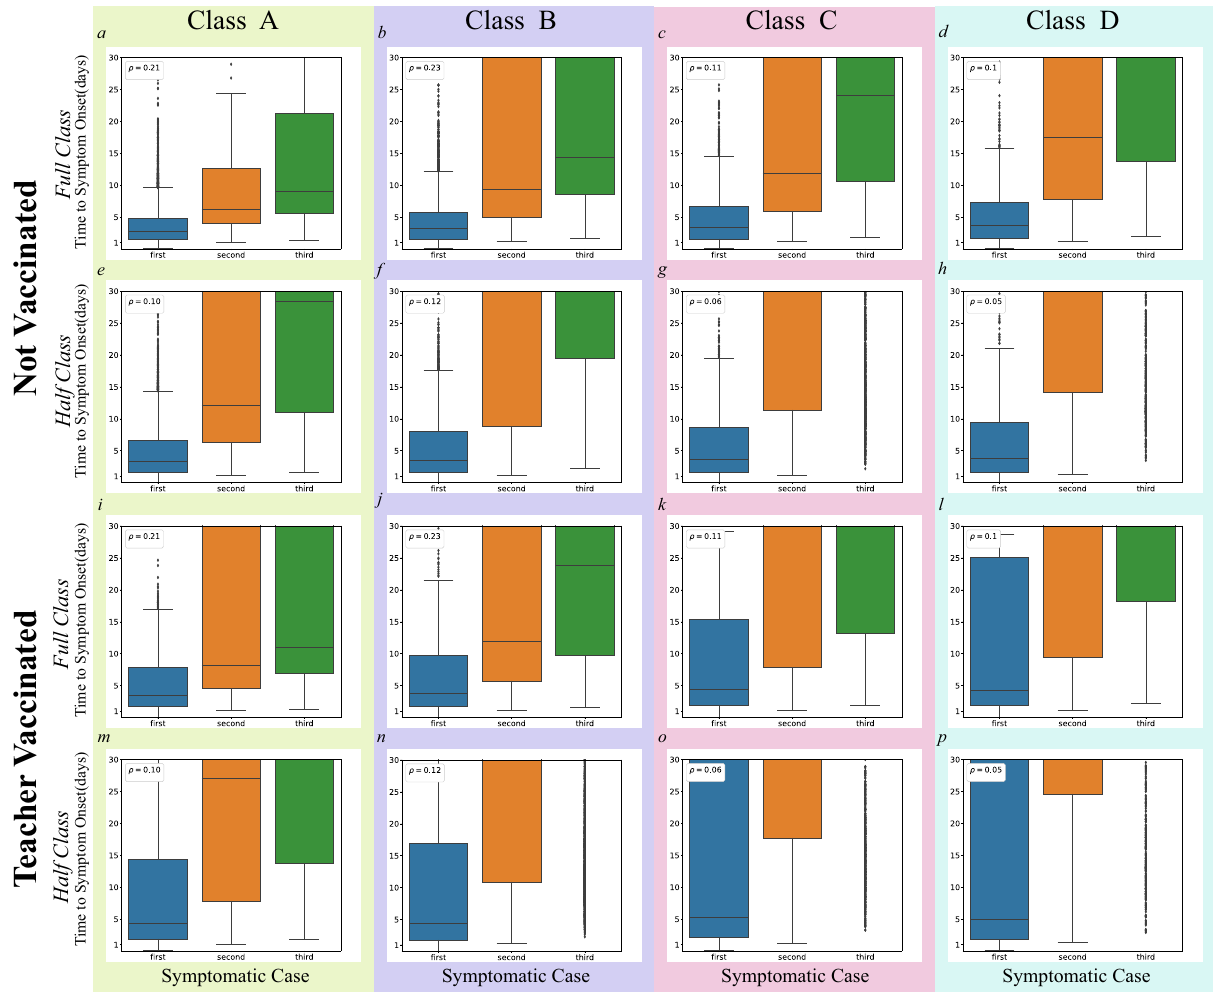
Figure 6. Time in days to the emergence of first, second, and third symptomatic individuals in classes A–D for teacher vaccinated and not vaccinated and for full and half-sized class scenarios. The horizontal axis labels nth symptomatic case. The vertical axis indicates time in days. Horizontal lines within each box indicate medians, and ρ ’s in each legend represent the classroom densities in the unit of people per m 2